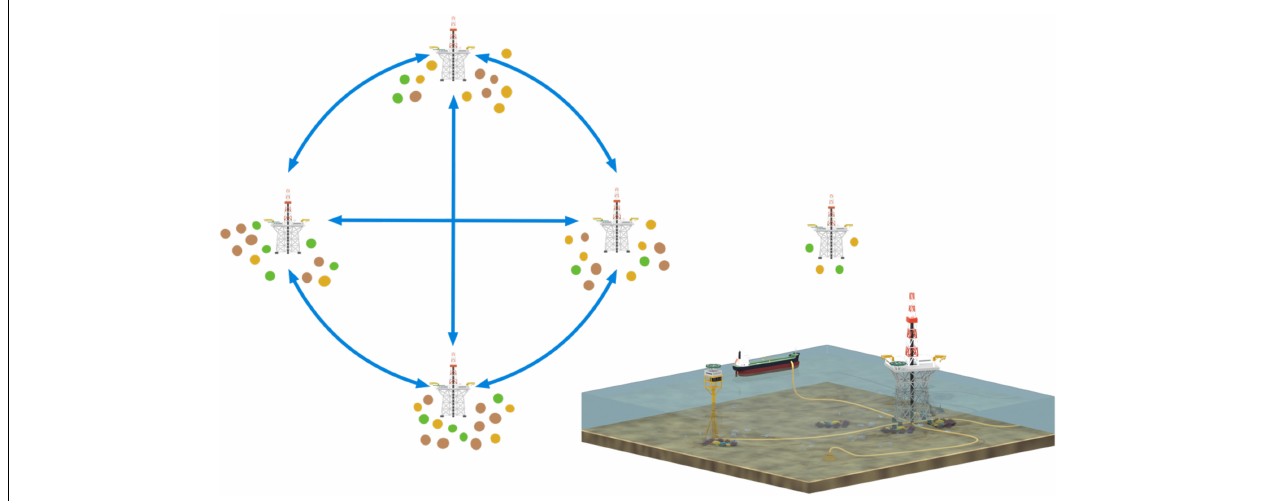
FIGURE 4 | Connectivity of biological particles (e.g., larvae) between oil and gas infrastructure in offshore environments depends on the proximity of structures to each other, pathways for connections (such as pipelines), pelagic larval duration (and behaviour), as well as patterns of oceanographic currents. Inset image shows a visual rendering of different types of co-located